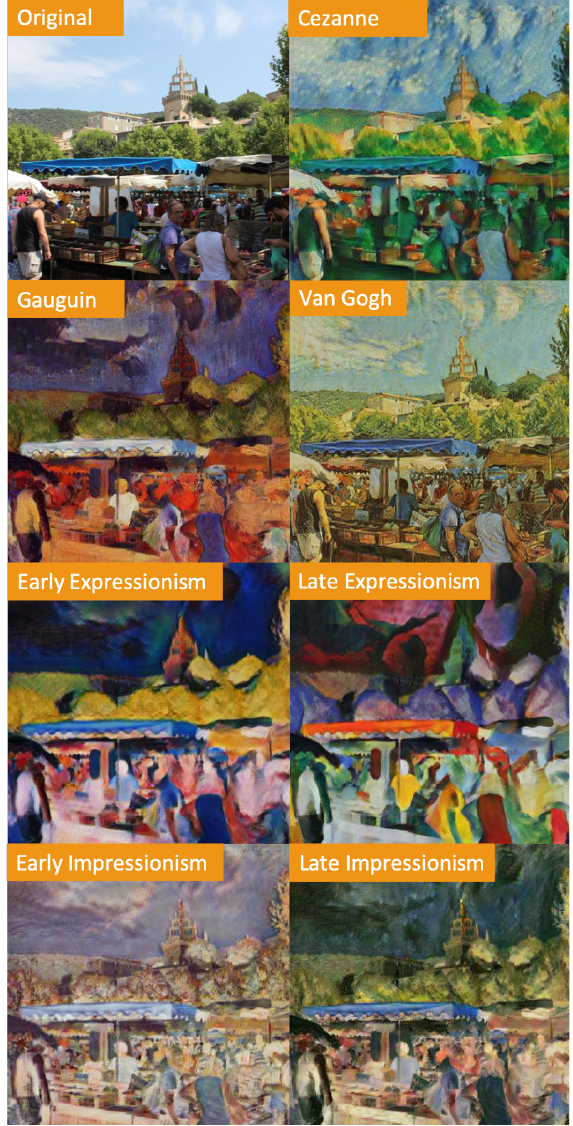
Figure 3. Example photograph (top left) transformed into the generated images of seven different styles using